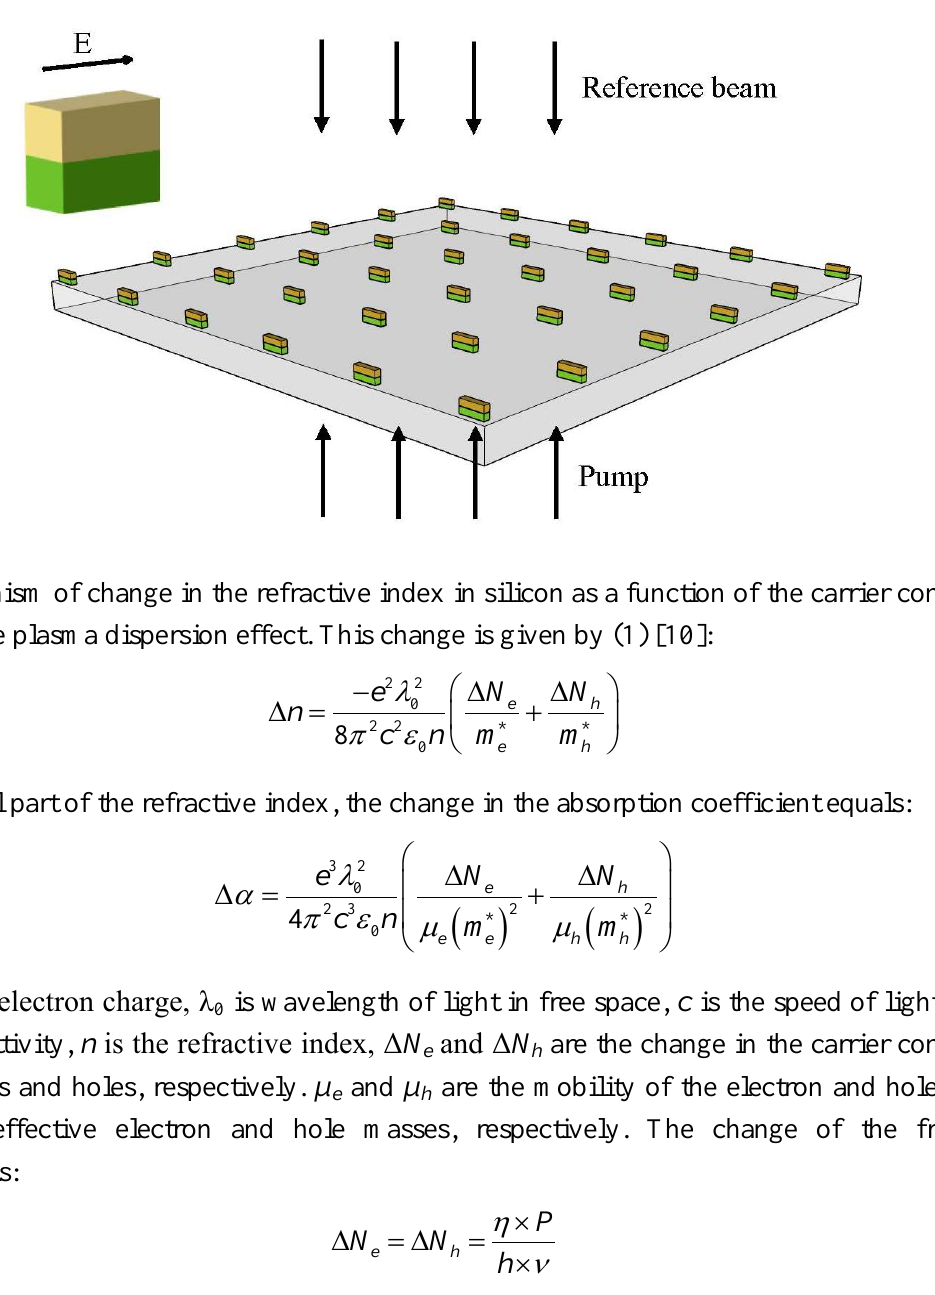
Figure 1. Schematic sketch of the